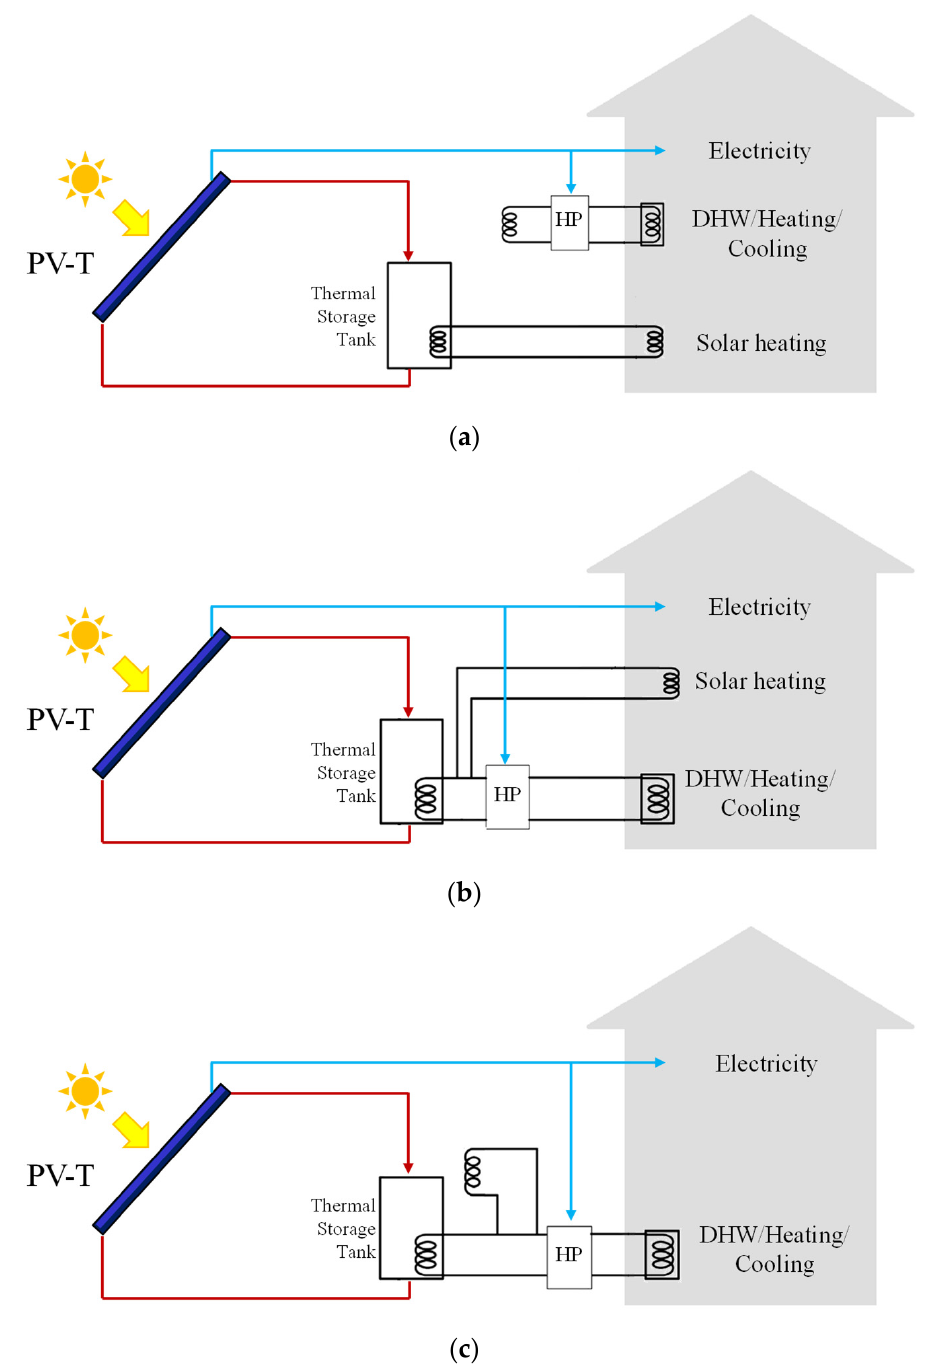
Figure 7. Schematic diagram of ( a ) a parallel air-to-water HP system, ( b ) a series water-to-water HP and system ( c ) a dual-source air-to-water HP system, all based on PV-T collectors. (Adapted with permission from [31] Copyright 2014 Elsevier B.V.)